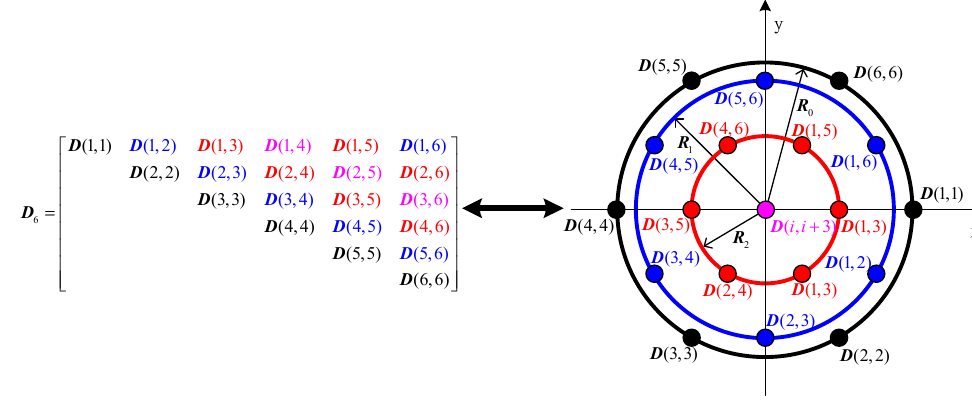
Figure 2. Matrix D 5 and the corresponding virtual array.